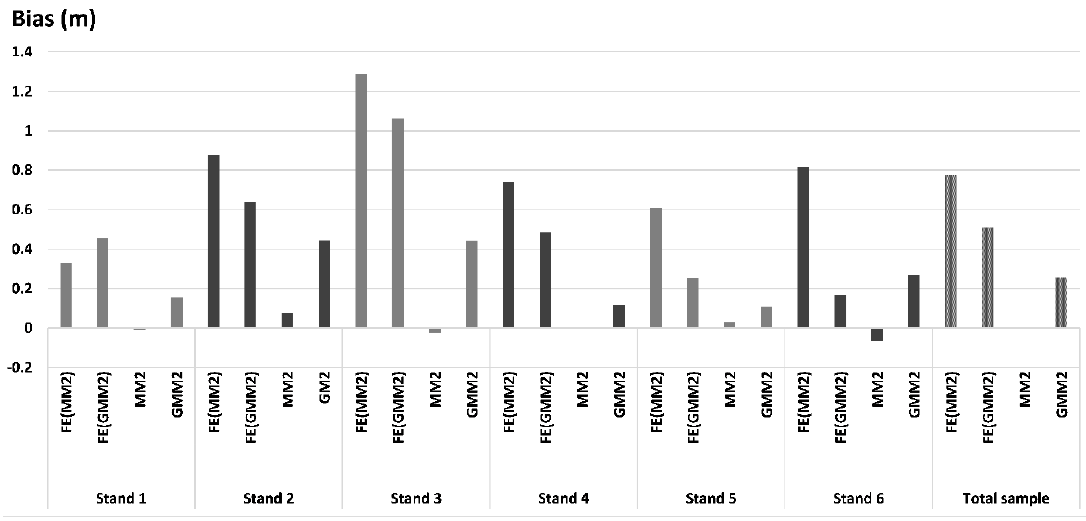
Figure 8. Mean prediction bias per sample plot and total sample during model evaluation against independent data of crown width-diameter.